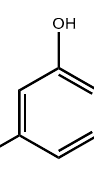
Figure 1. Structure of phloroglucinol.